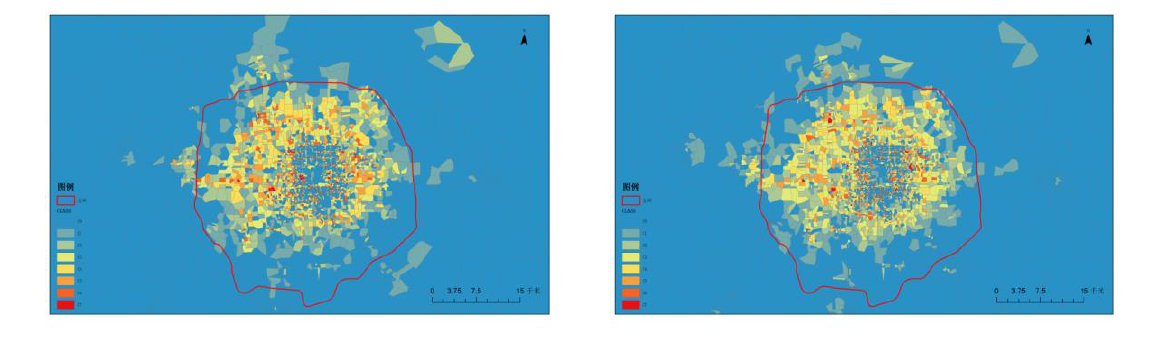
Figure 3 (A). The clustering results of O-point Figure 3(B). The clustering results of D-point Figure 3. The clustering results of 16: 00 ~ 19: 00 on weekday